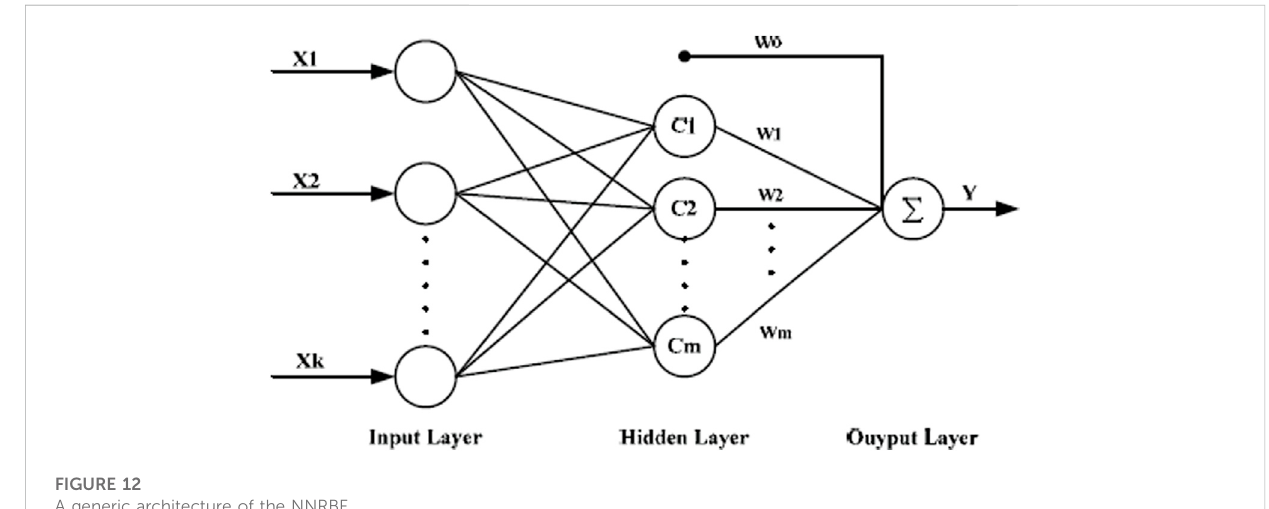
FIGURE 12 A generic architecture of the